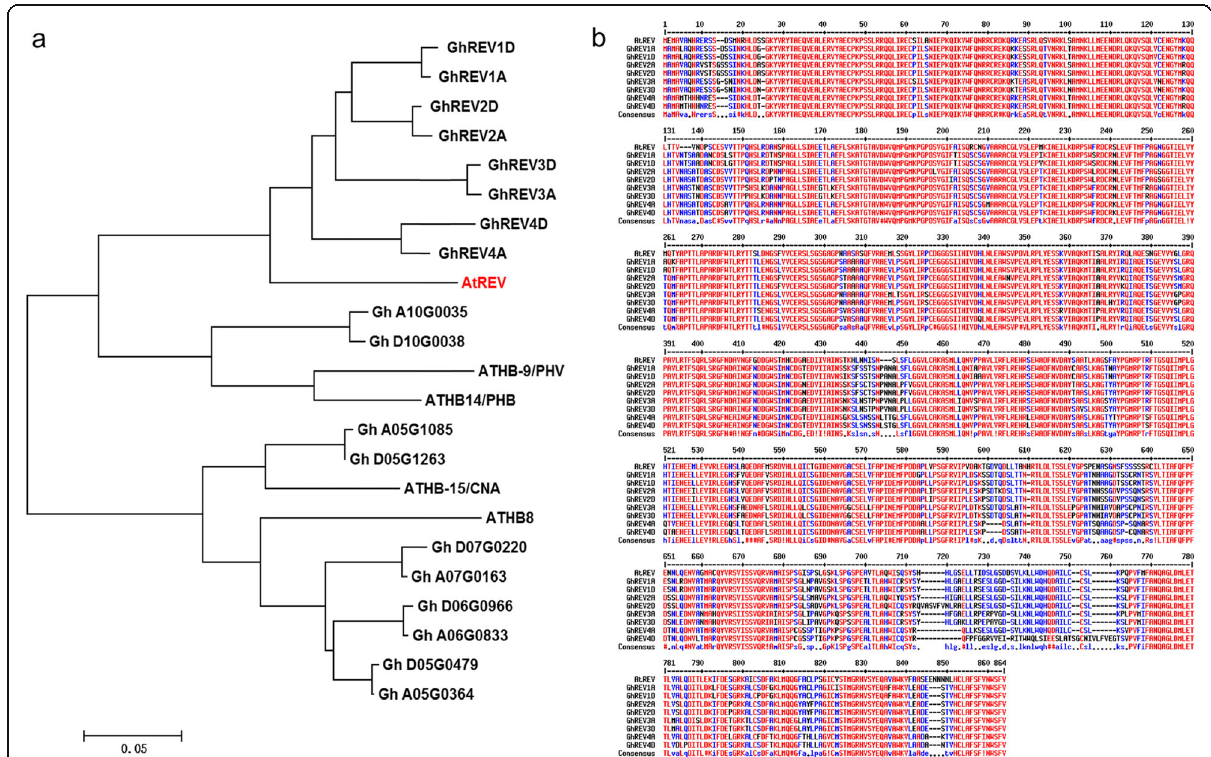
Fig. 1 Sequence analysis of Gossypium hirsutum REVOLUTA (GhREV ) . (a) Phylogenetic tree of HD-ZIP III family in both cotton and Arabidopsis . The tree was drawn to scale with branch lengths in the same unit. (b) The amino acid sequence alignment of REV in cotton and